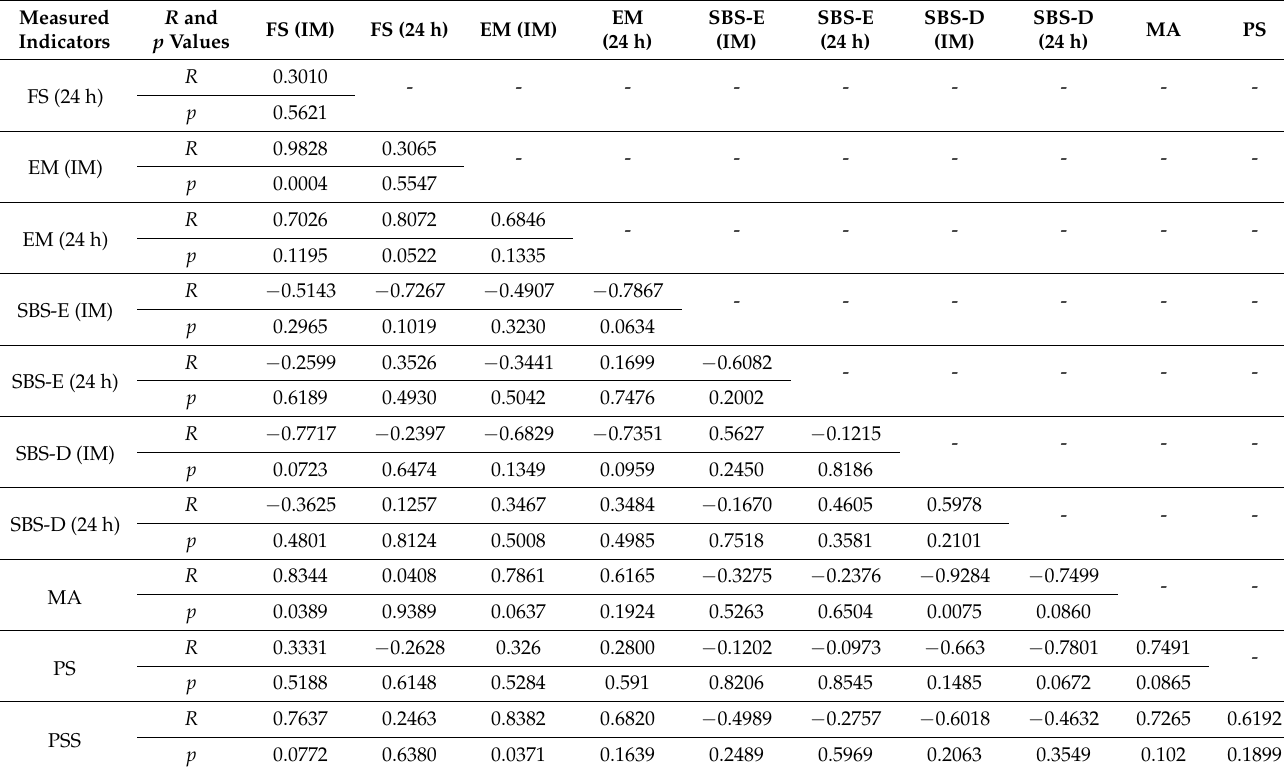
Table 5. Regression Analysis between Flexural Strength (FS), Elastic Modulus (EM), Shear Bond Strengths to Enamel (SBS-E) and Dentin (SBS-D), Marginal Adaptation (MA), and Polymerization Shrinkage (PS) and Stress (PSS) immediately after polymerization (IM) and 24